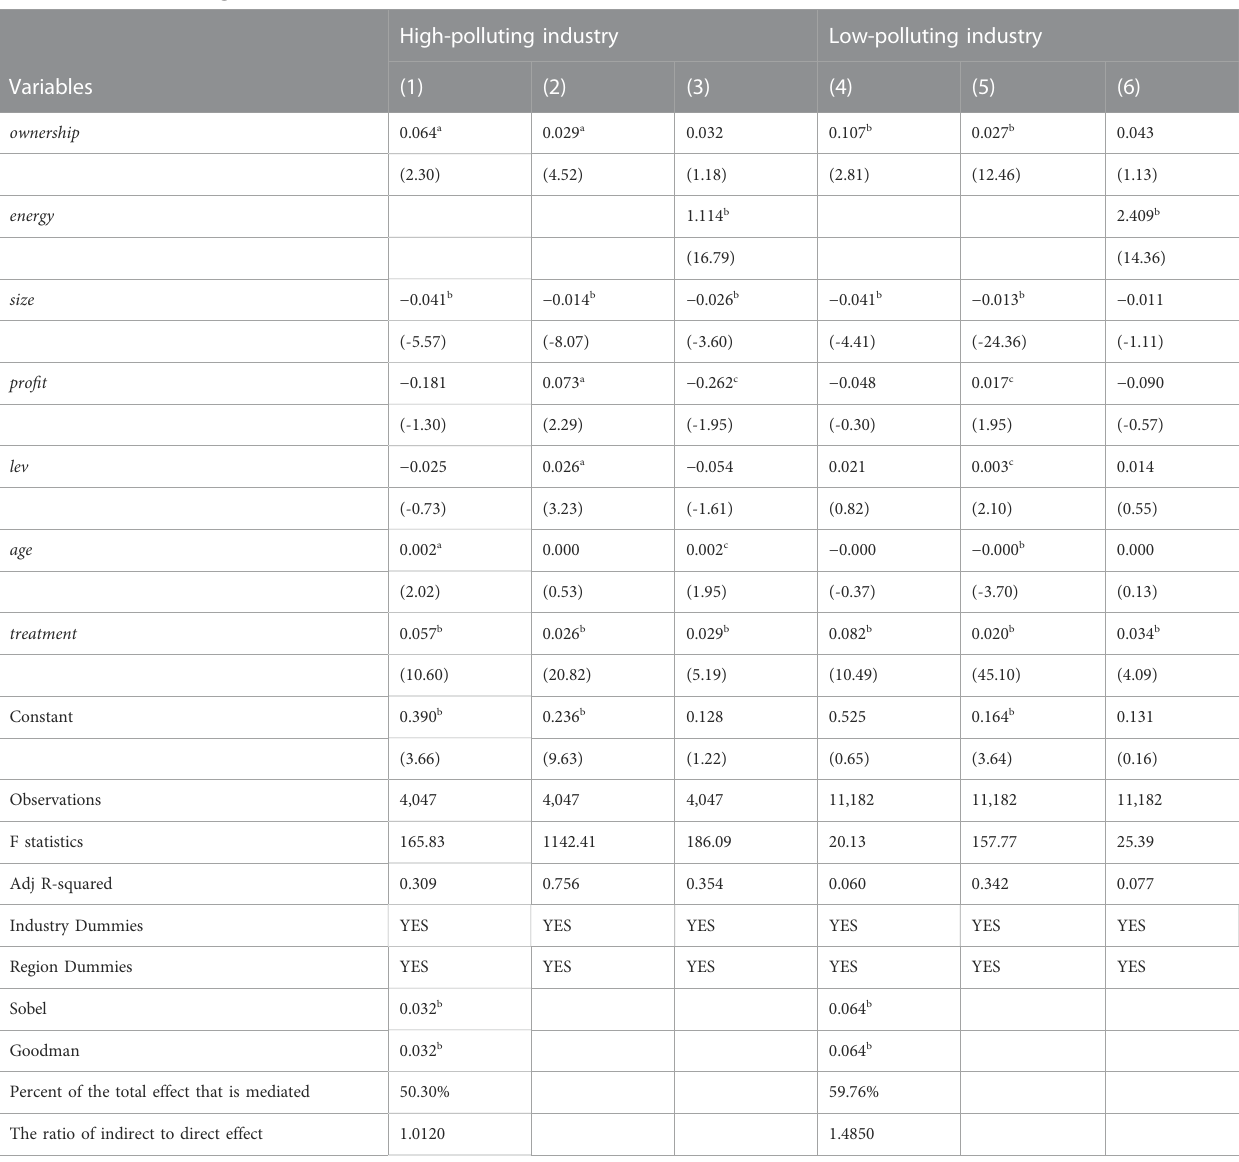
TABLE 3 Mediation effect regressions in different